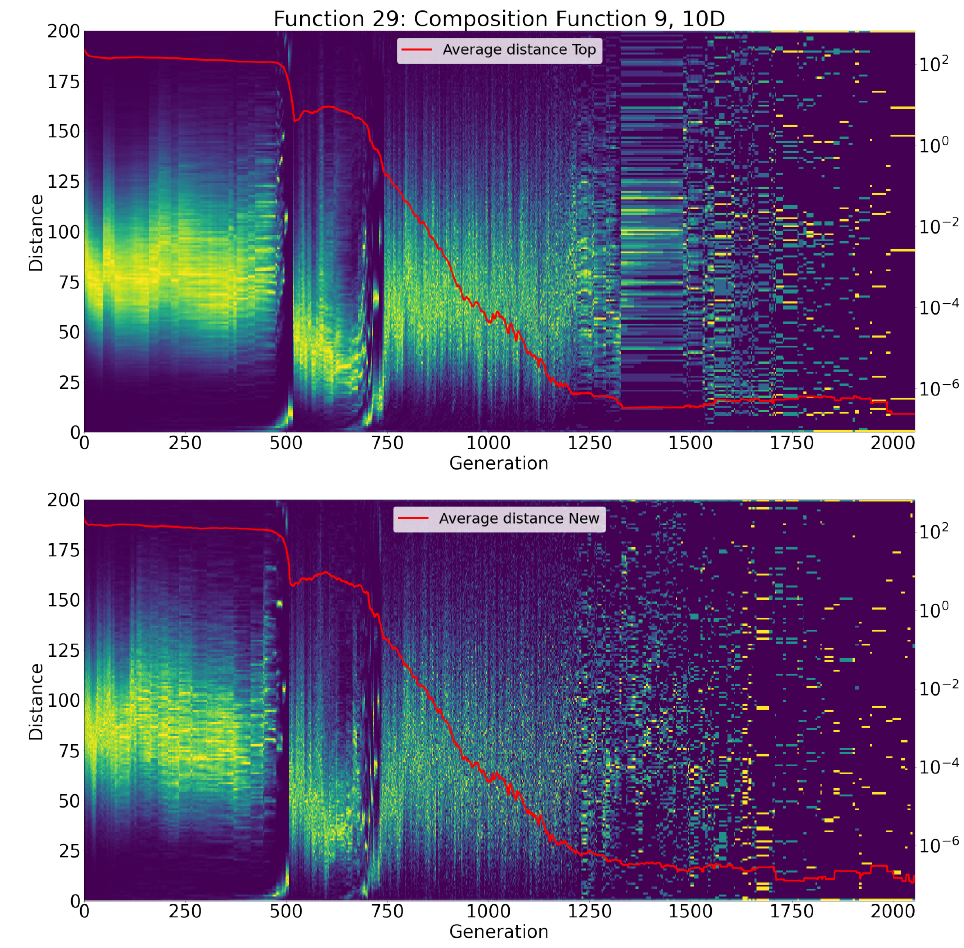
Figure 4. Heatmap of pairwise distance histograms on every generation, F29, CEC 2017, 10 D